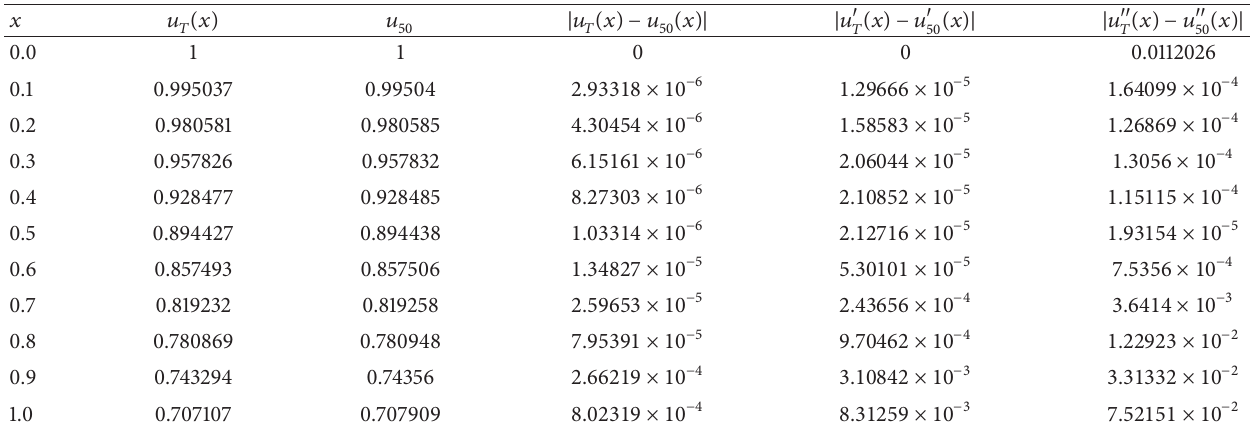
Figure 3: Present numerical method for Example 3. Table 2: Numerical solutions for Example